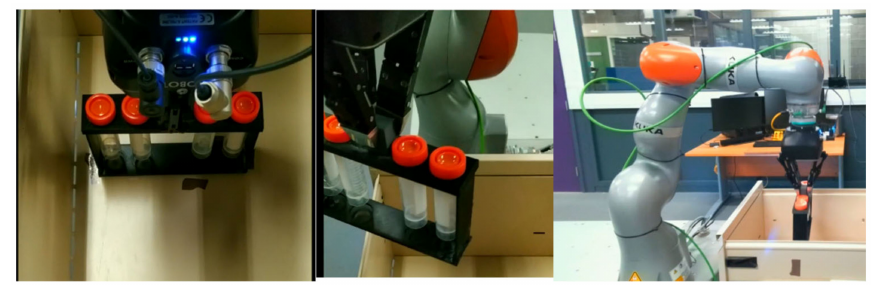
Figure 9. Robot reaching inside the storage cabinet to grasp the